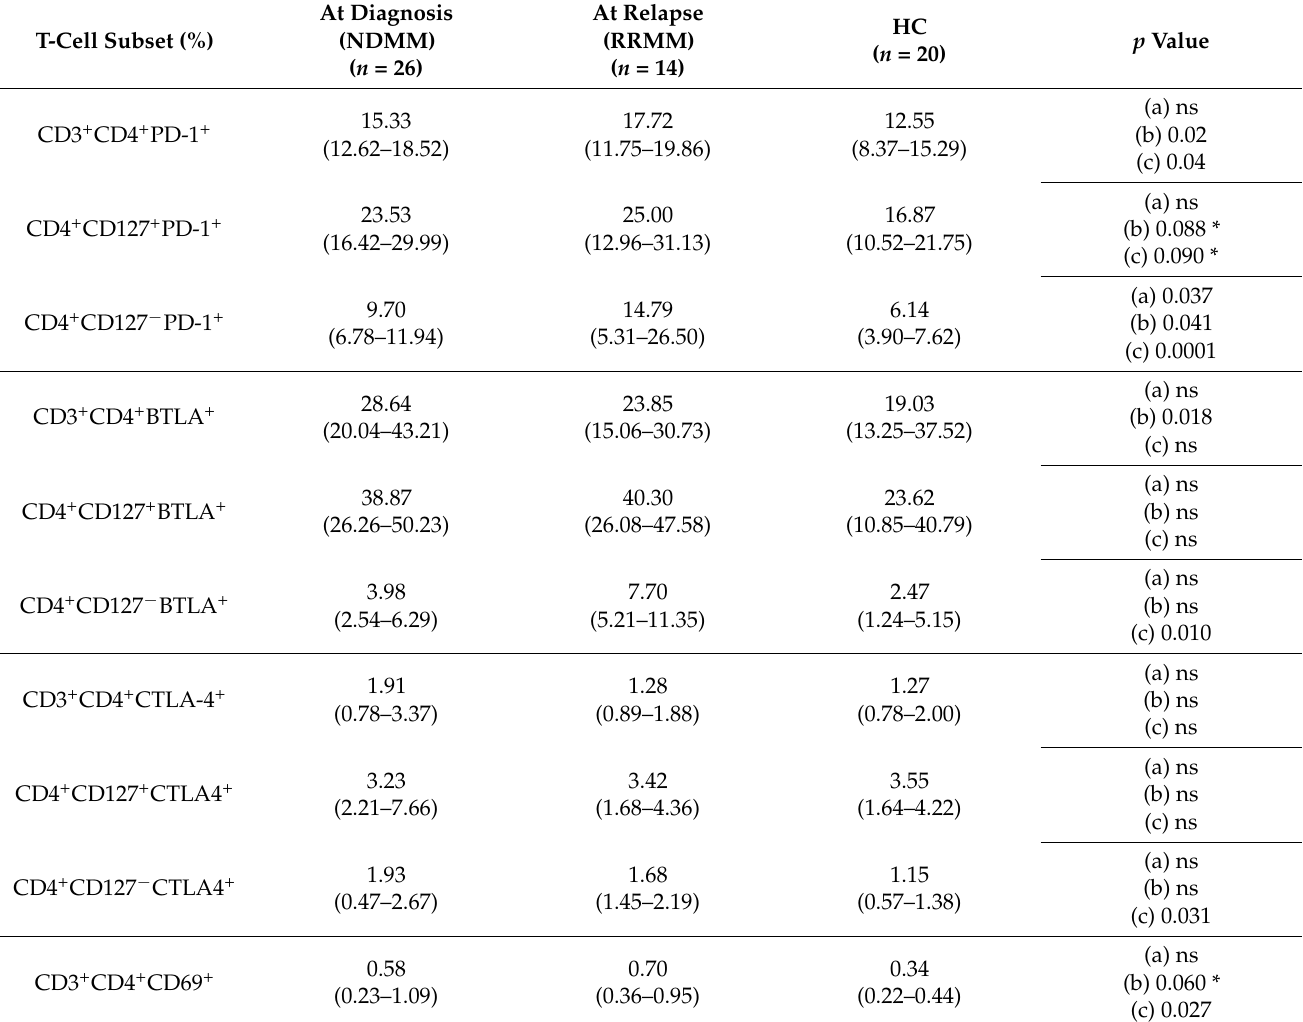
Table 1. Immune checkpoint and CD69 expression (%) in PB CD4 T cell subsets in different MM phases and healthy controls